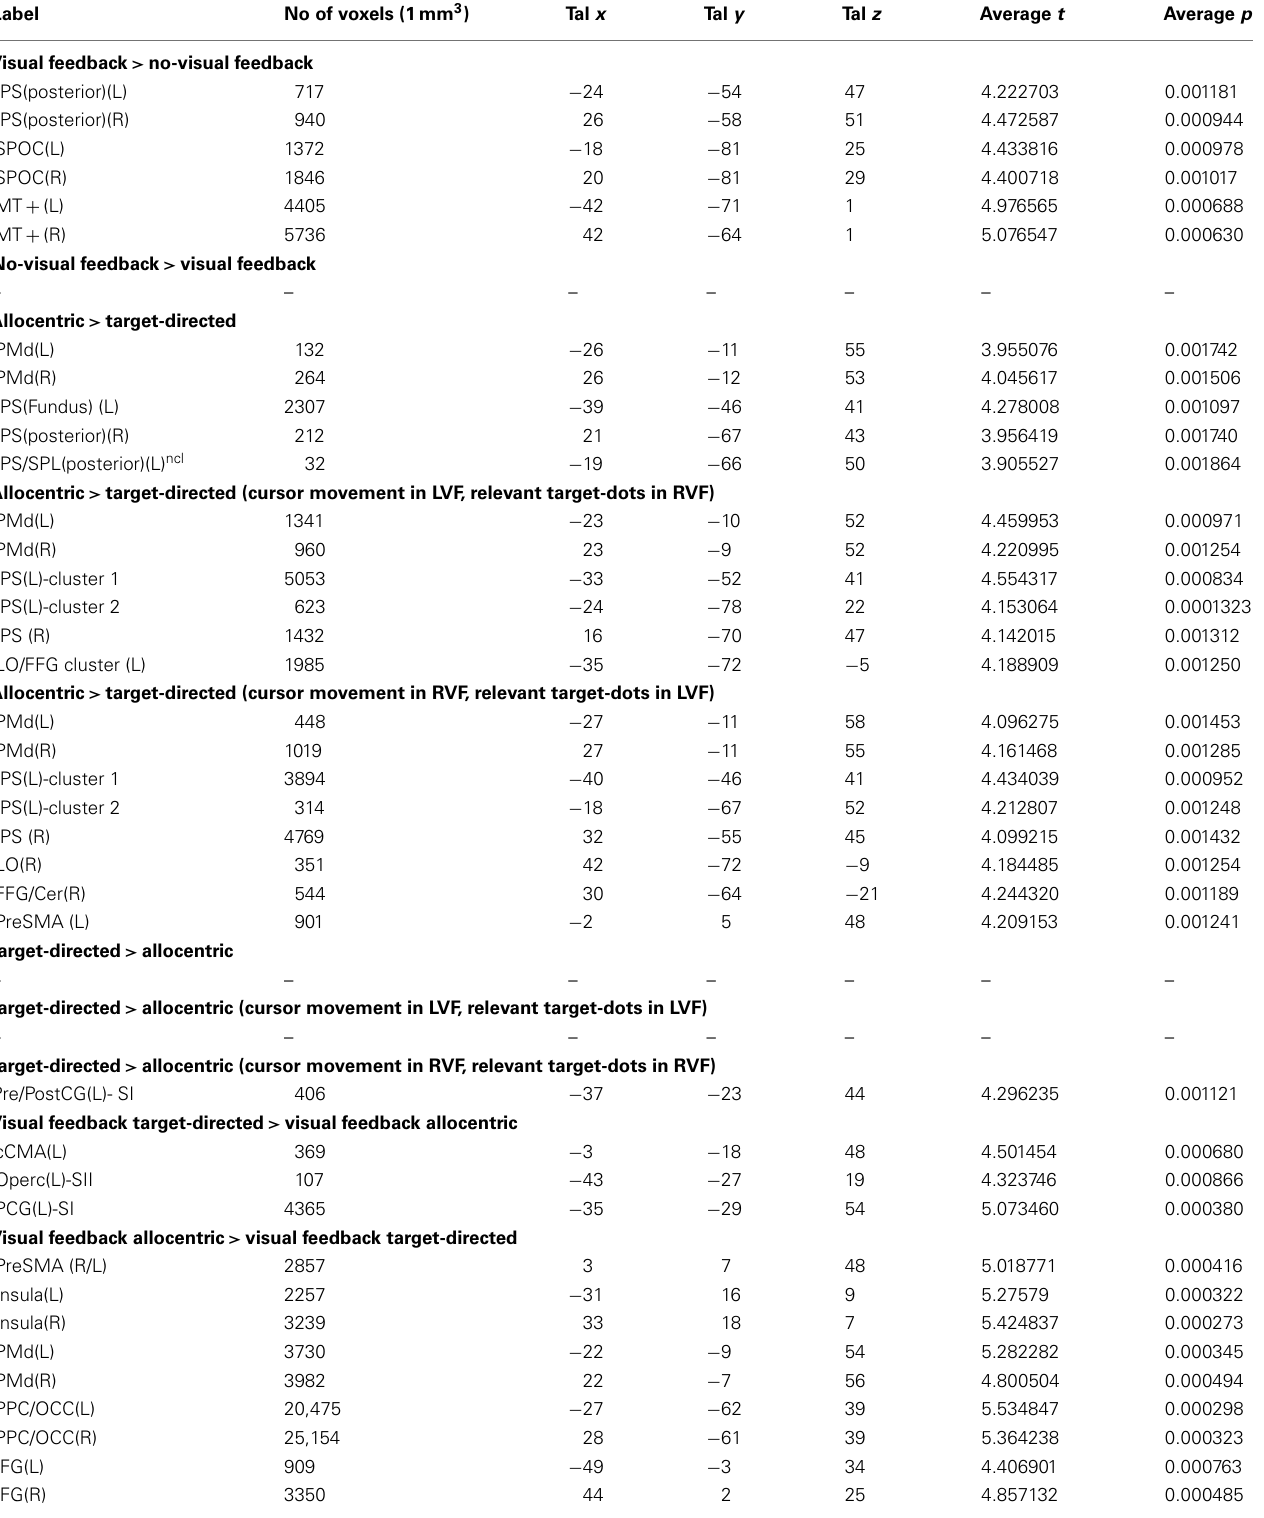
Table 3 | Results of conjunction analyses defined inTable